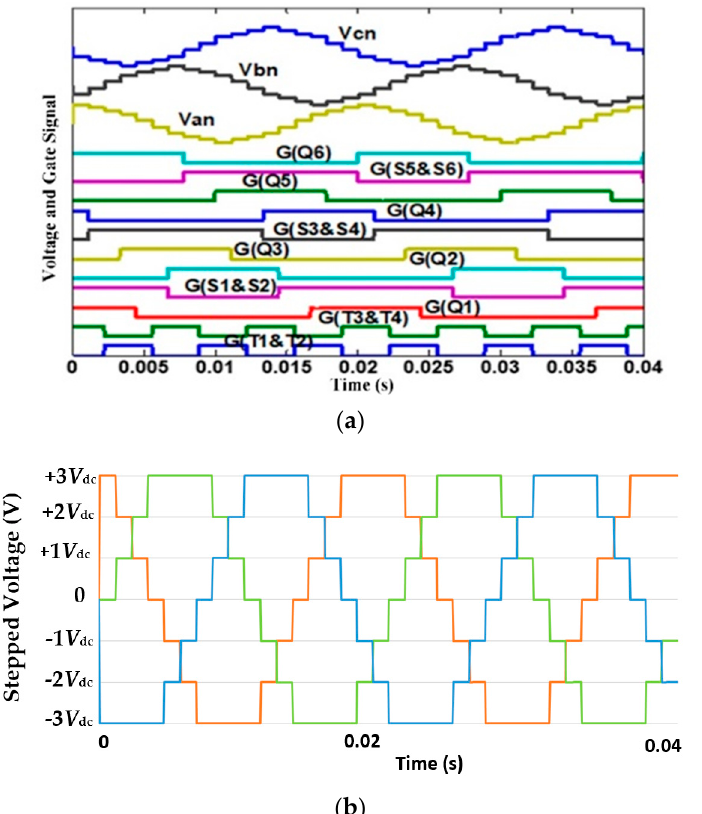
Figure 6. Idealized waveforms. ( a ) Gate signals and the line-to-neutral voltages V cn, V bn, and Van. ( b ) Waveforms for the line-to-line voltages V ab, V bc, and V ca.